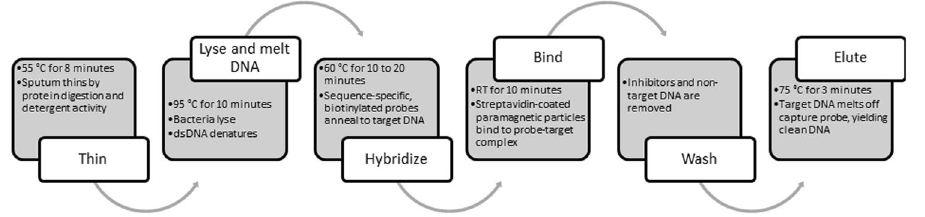
Figure 1. Schematic of sequence specific capture work flow: six steps, Thin, Lyse & Melt, Hybridize, Bind, Wash and Elute are indicated with corresponding times and temperatures detailed.